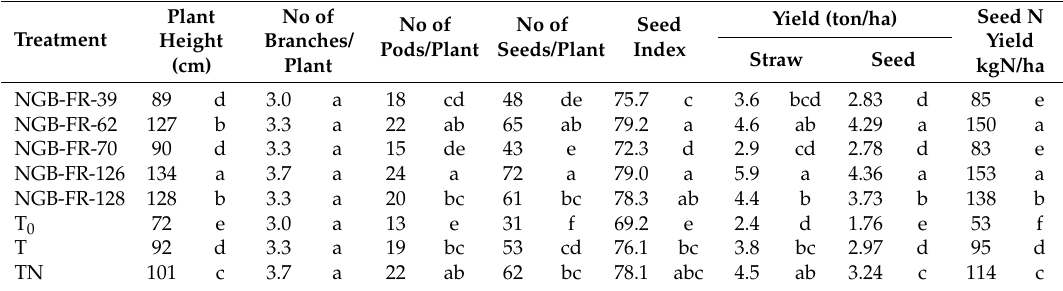
Table 5. Effect of different rhizobial strains on nodulation, growth parameters, and shoot N content of faba bean plants after 50 days of sowing under field conditions (winter growing season 2013/2014). Dry wt. of Nodules Treatment